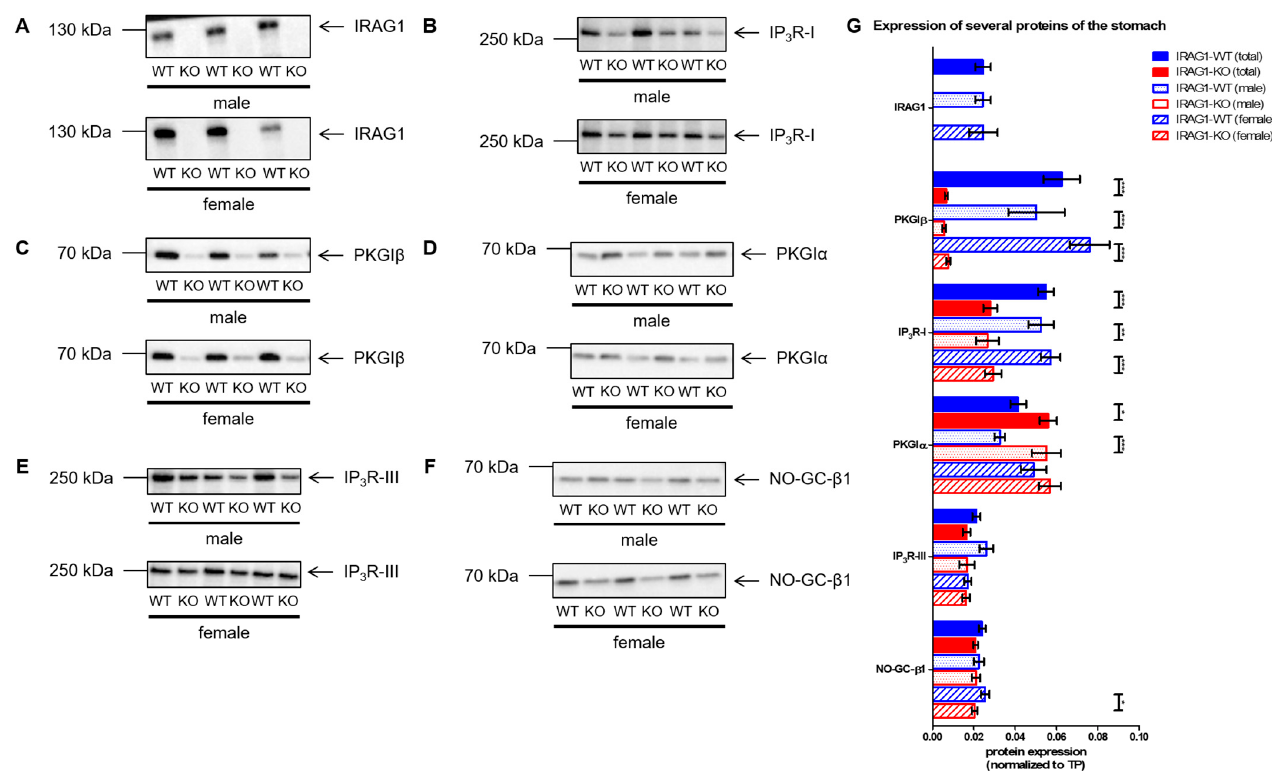
Figure 7. The expression of several cGMP/PKGI signaling proteins in stomachs from IRAG1-KO (KO) and IRAG1-WT (WT) mice. Protein expression of IRAG1-KO mice and their WT littermates (respective age: 15 weeks) were analyzed by Western blot ( A – F ) and normalized to total protein (TP) ( G ). ( A ) Western blot of IRAG1 in IRAG1-WT (total: n = 22; male: n = 12; female: n = 10) and IRAG1-KO mice (total: n = 23; male: n = 11; female: n = 12). ( B ) Decreased expression of IP 3 R-I in IRAG1-KO mice (total: n = 22; male: n = 12; female: n = 10) compared to IRAG1-WT mice (total: n = 22; male: n = 12; female: